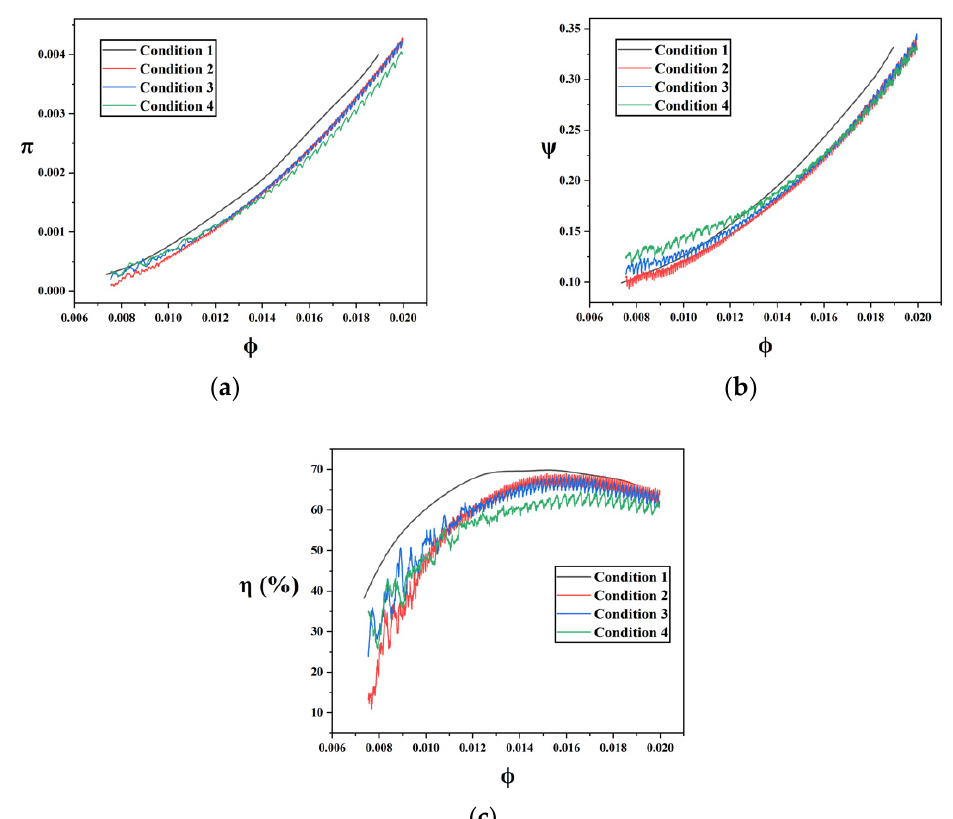
Figure 11. Power number curves ( a ), head number curves ( b ), and efficiency curves ( c ) for different working conditions.